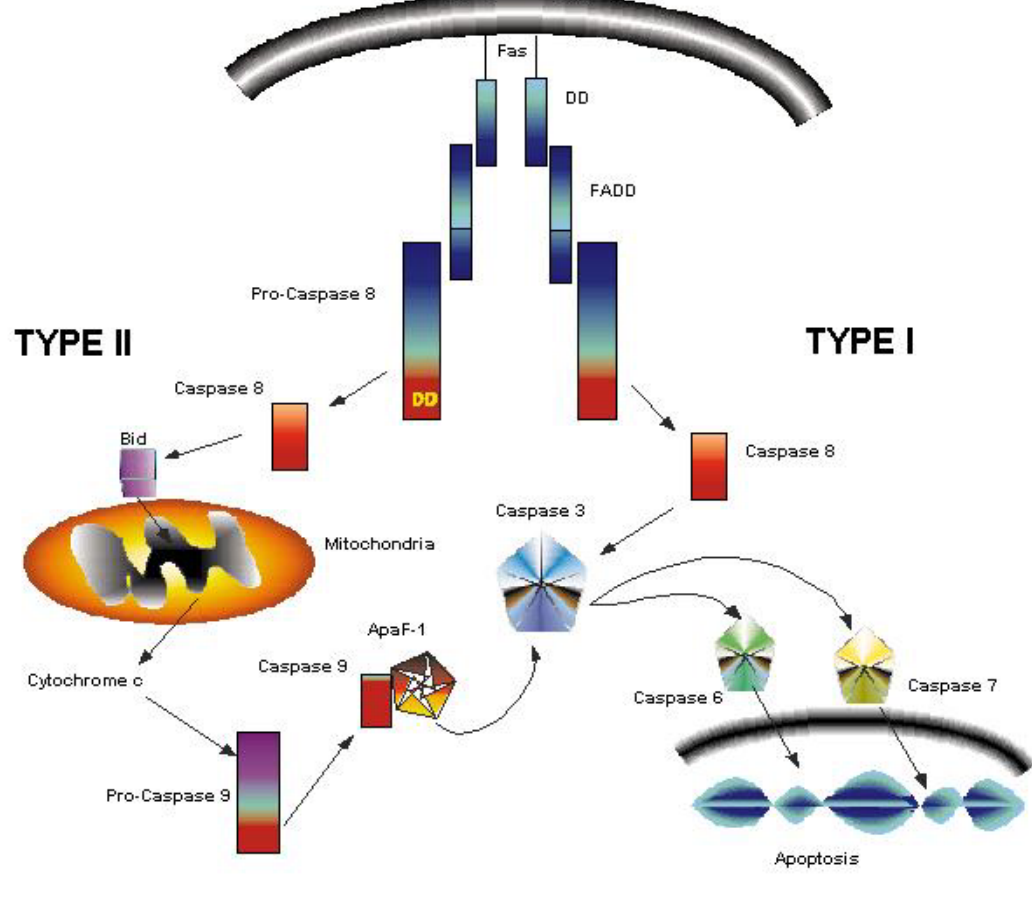
FIGURE 2 . Schematic representation of the intracellular components of the Fas/FasL